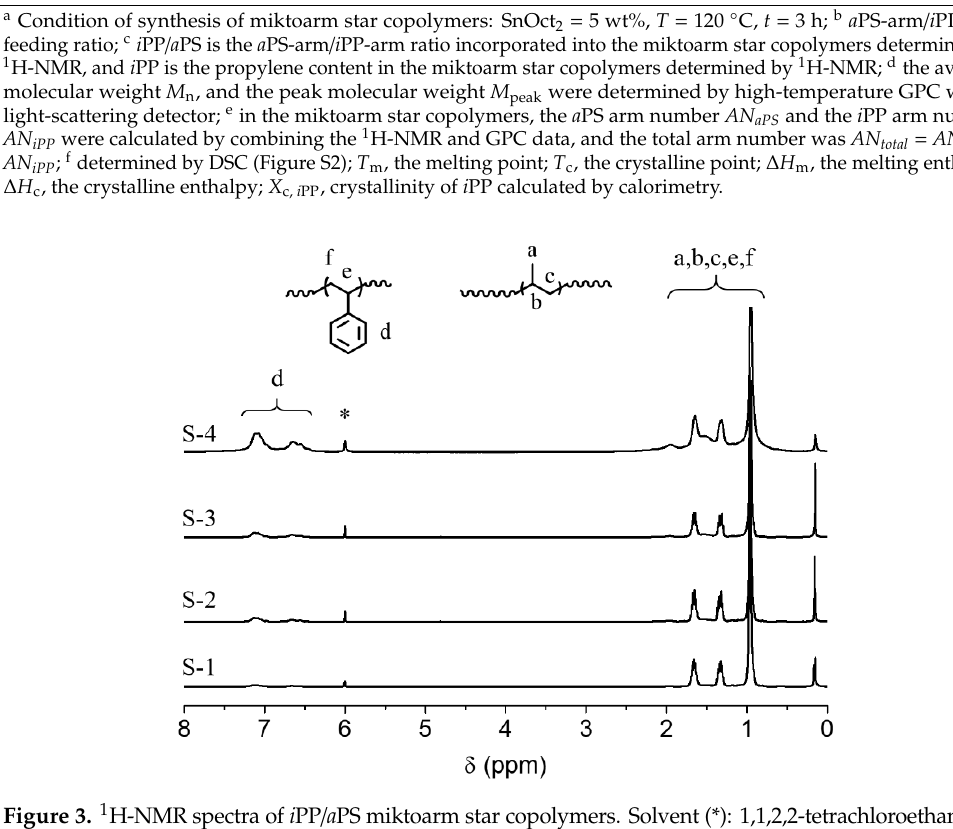
Figure 3. 1 H-NMR spectra of i PP / a PS miktoarm star copolymers. Solvent (*): 1,1,2,2-tetrachloroethane- d 2 .